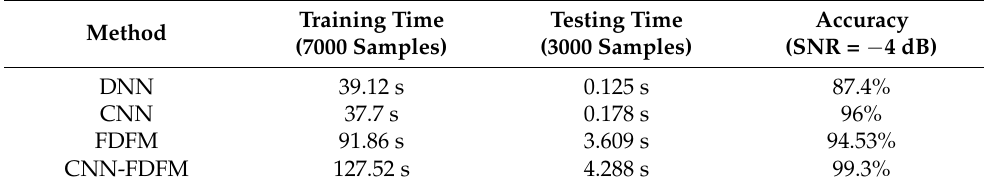
Table 6. The computation time of each method with 7000 training samples and 3000 test samples.